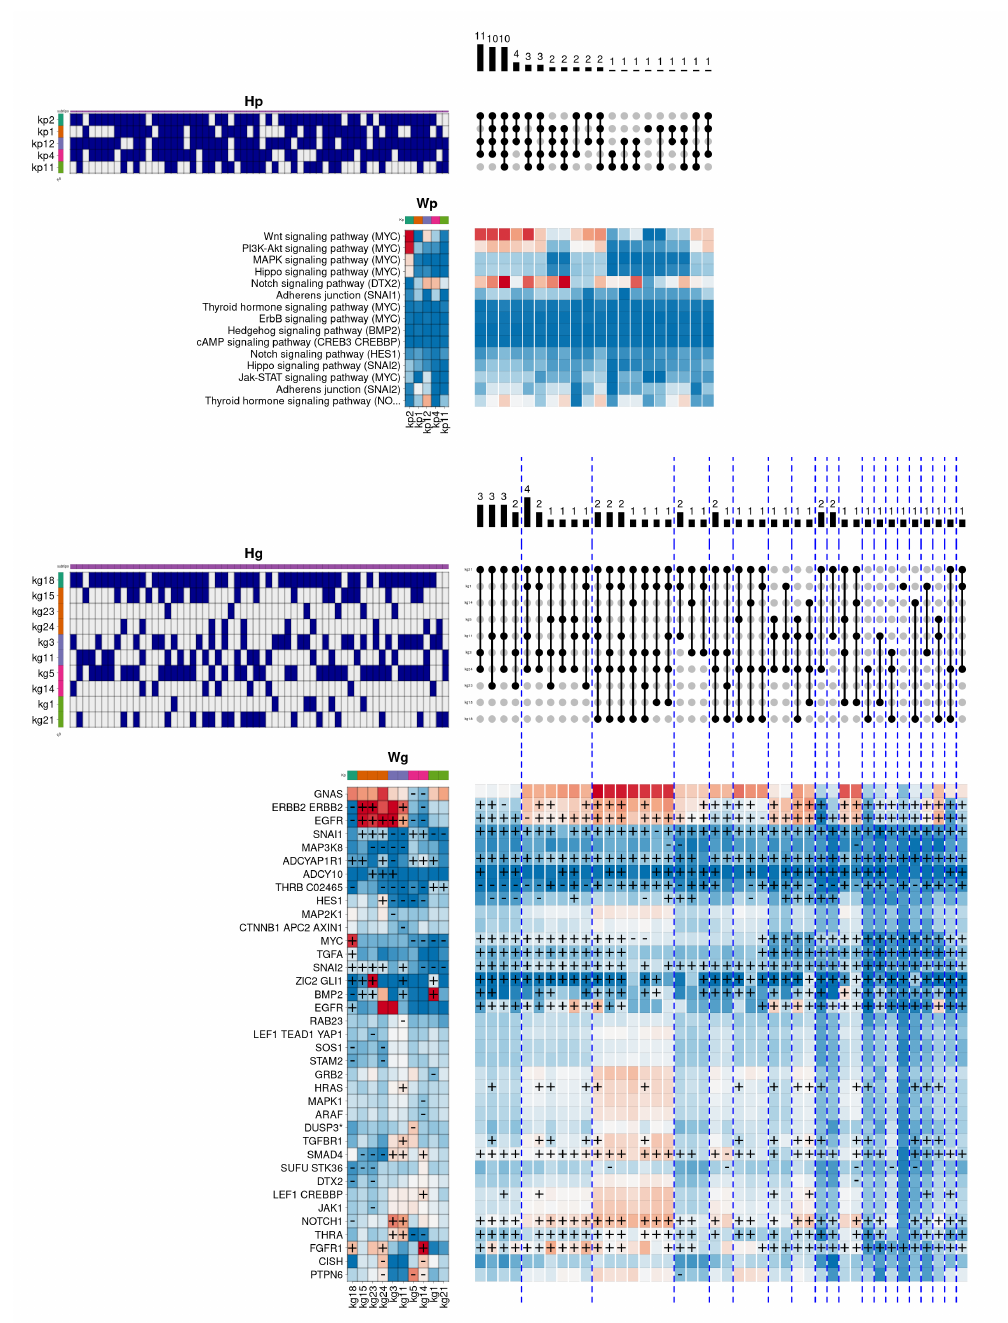
Figure 6. Graphical representation of the hierarchical model obtained for the biological function Notch signalling , applied to the Basal subtype.The most frequent pathway-level combination relies on the components kp2 (dark green), kp12 (magenta), and kp4 (pink) components, overactivating signalling cascades from the Wnt , PI3K-Akt , MAPK , Hippo , and Adherens junction pathways. Interestingly, the combination also activates the Notch signalling pathway, highly relevant in the Basal subtype. At the gene space, these components include several cancer-related genes such as MYC , EGFR , SNAI1 , or NOTCH1 , among